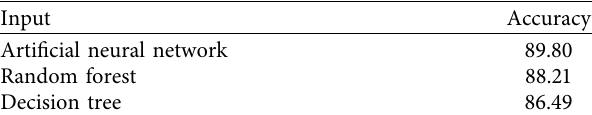
Table 13: Accuracy of each